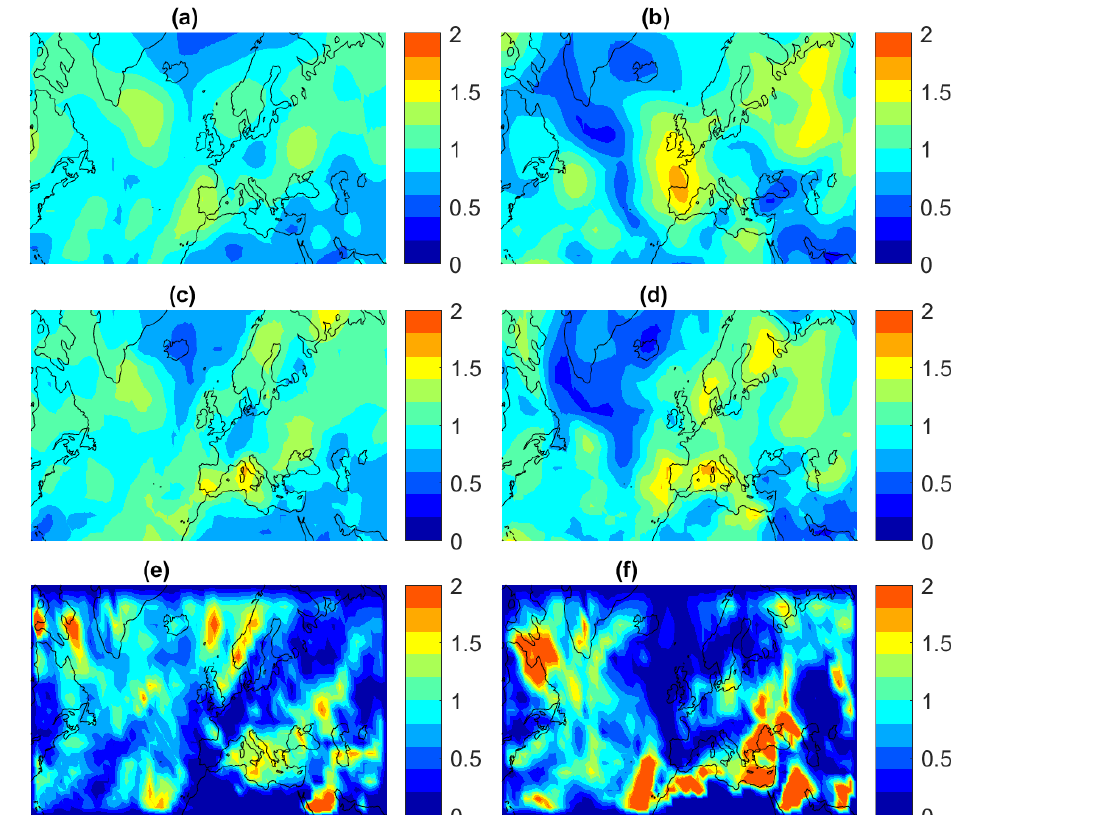
Figure 5. Cluster uncertainty. Standard deviation of temperature at 850hPa [ ◦ C] (a, b) , 2m temperatures [ ◦ C] (c, d) and precipitation rate [mmd − 1 ] (e, f) of the two clusters of cold spells in Italy found via k